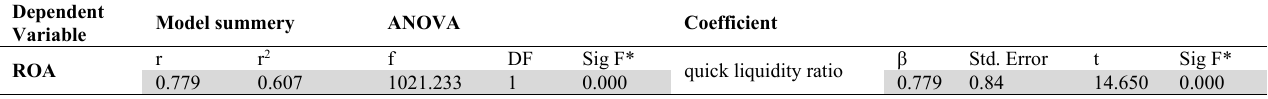
Simple regression test results, the effect of quick liquidity ratio at return on assets Dependent Model Variable